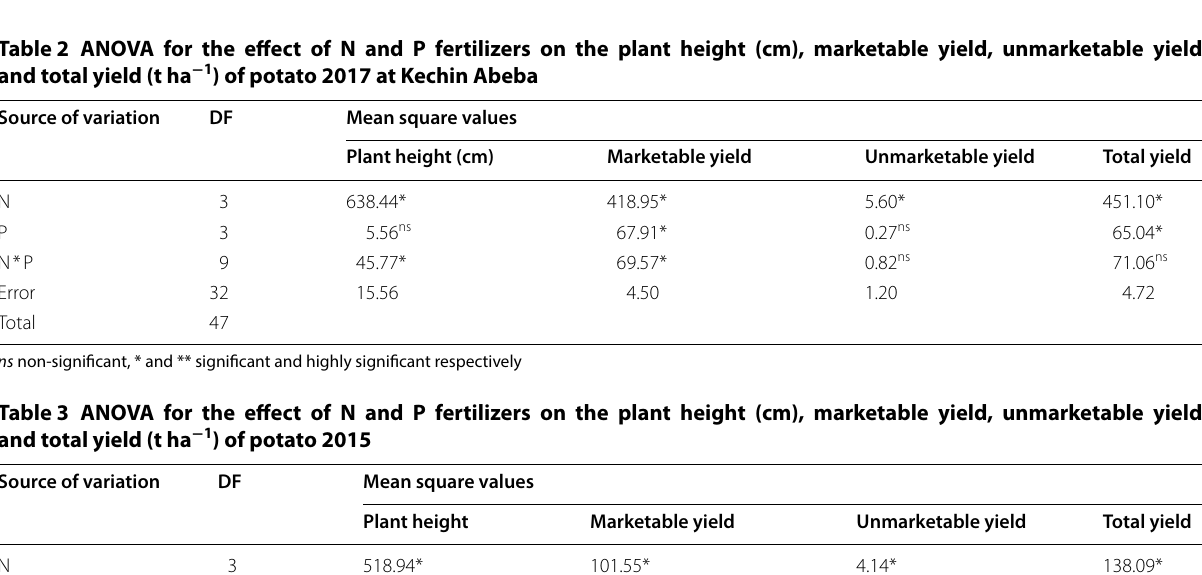
Table 2 ANOVA for the effect of N and P fertilizers on the plant height (cm), marketable yield, unmarketable yield and total yield (t ha − 1 ) of potato 2017 at Kechin Abeba Source of variation